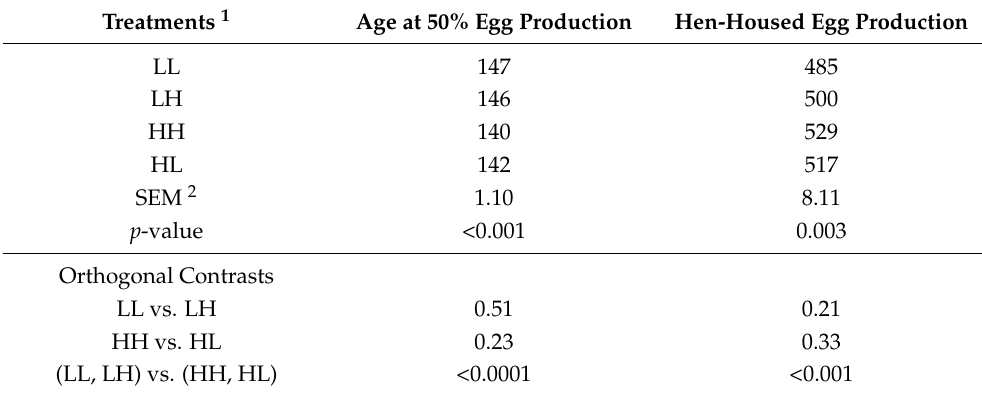
Table 4. Age at 50% egg production and hen-housed egg production of laying hens in response to dietary balanced protein levels in the development and laying periods.